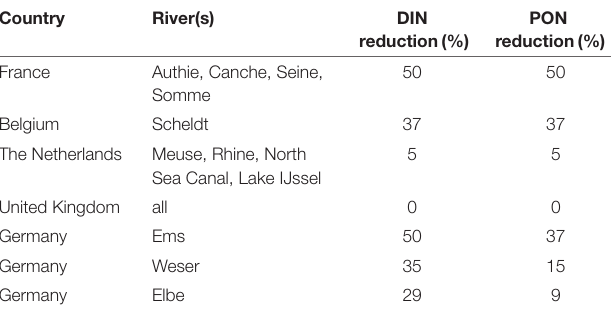
TABLE 1 | DIN and PON reduction levels for the WFD reduction scenario.